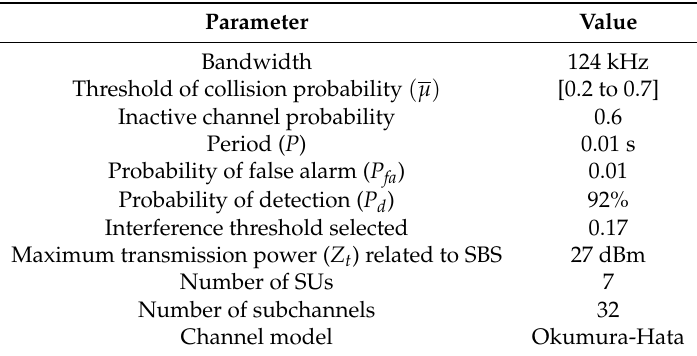
Table 1. Parameters selected for the simulation.